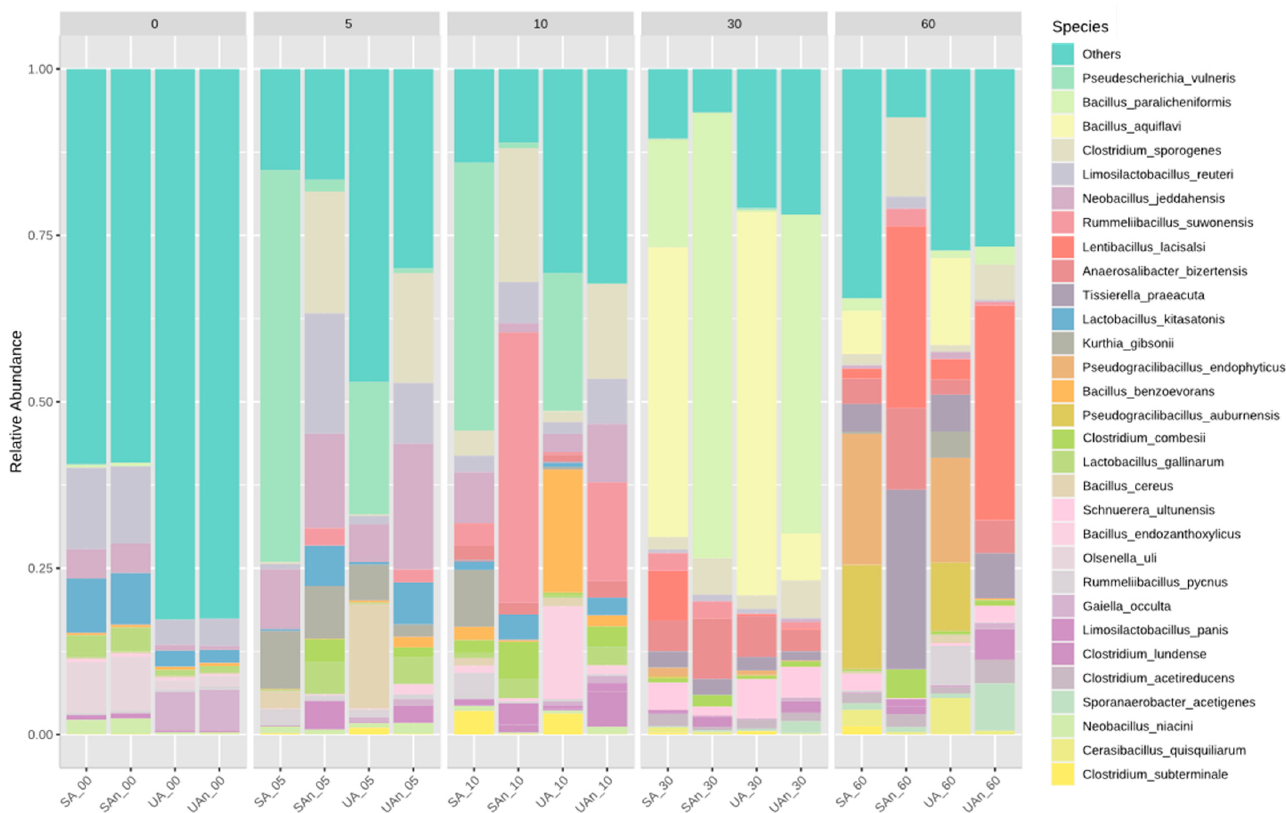
Figure 8. Relative abundance of the top 30 most abundant species during decomposition of poultry carcass. “Others” represent taxa with counts <10. UA, unsterilized soil–aerobic condition; SA, sterilized soil–aerobic condition; UAn, unsterilized soil–anaerobic condition and SAn, sterilized soil–anaerobic condition. The 0, 5, 10, 30, and 60 represent the sampling period.